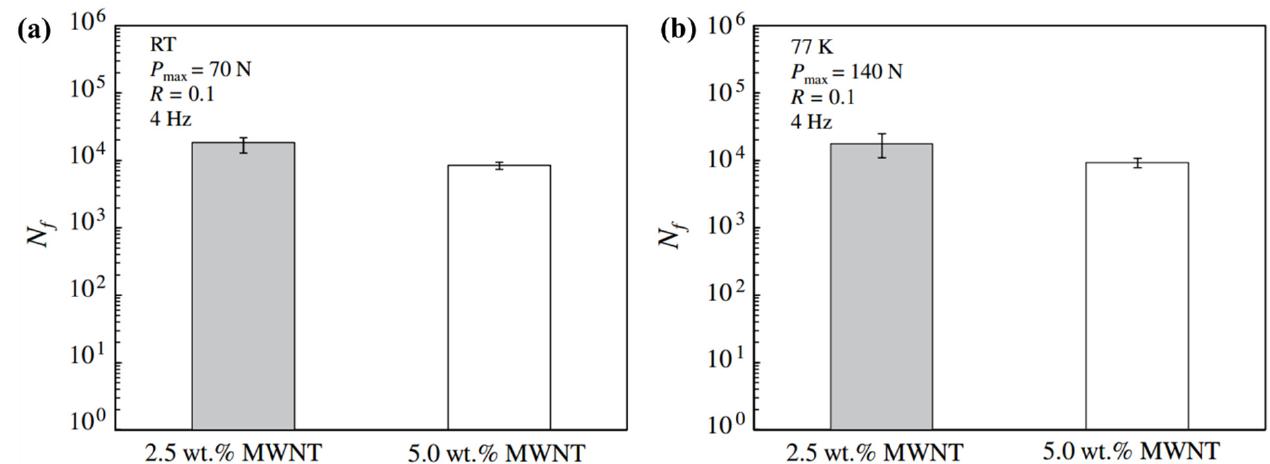
Figure 10. Fatigue lives of CNTS/polycarbonate composites at ( a ) room temperature and ( b ) 77 K. Reused with permission from Ref. [139]. Copyright 2014 Elsevier.